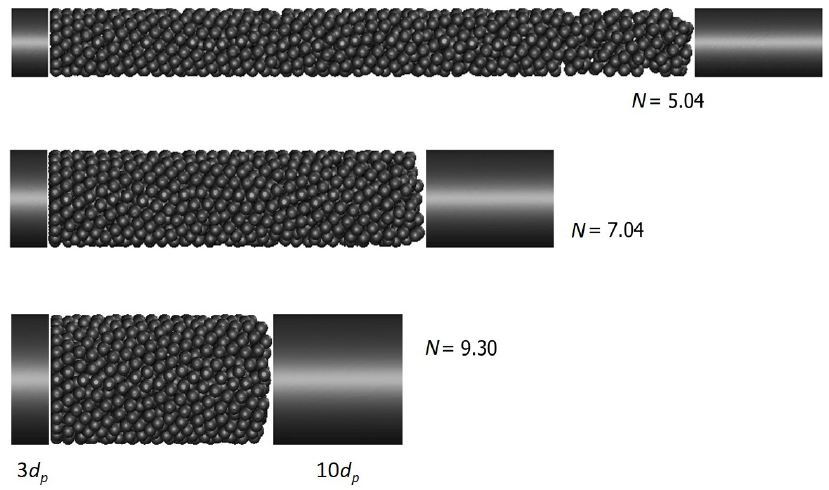
Figure 1. Cut-away views of three computer-generated beds: N = 5.04, N = 7.04 and N = 9.3 with the short unpacked inlet sections and the longer unpacked outlet sections.